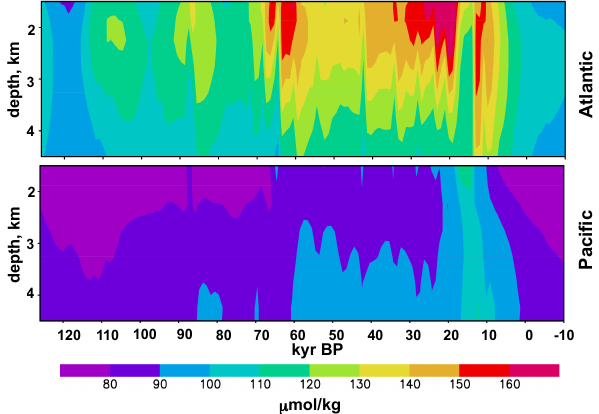
] 3 Fig. 6. Vertical distribution of the CaCO 3 fraction (%) in the top layer of seafloor sediments averaged over 30 ◦ S–30 ◦ N, Pacific (left panel) and Atlantic Ocean (right panel). Thick lines are re- sults of the PCBL simulation and thin lines are for the coretop CaCO 3 preservation data from Catubig et al. (1998) averaged on the CLIMBER resolution. Black lines and open circles are for pre- industrial (PI, 0kyrBP), red lines and closed squares are for the LGM